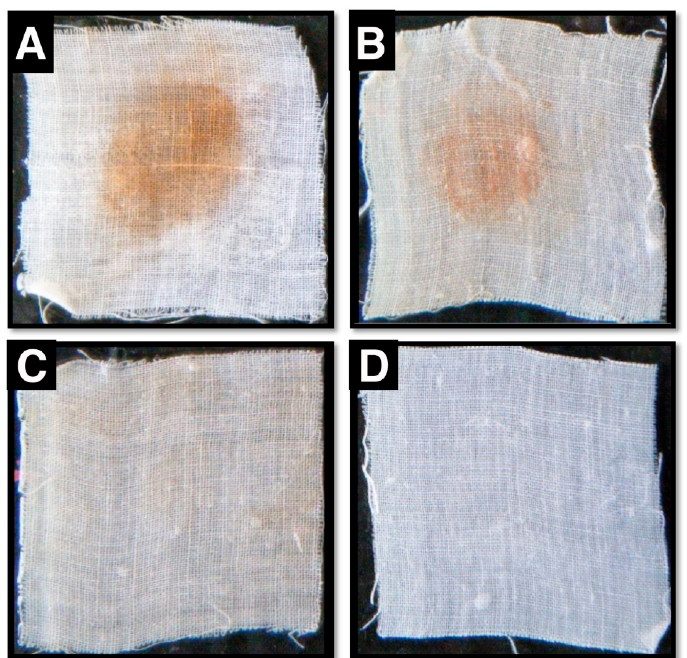
Figure 4. B. megaterium -TK1 protease-mediated cleaning performance of blood-stained fabrics. ( A ) Blood-stained fabric control. ( B ) Blood-stained fabric cleaned with detergent. ( C ) Blood-stained fabric cleaned with protease. ( D ) Blood-stained fabric cleaned with detergent and protease. Fotos were taken from cotton fabric square pieces (4 cm × 4 cm). Biology 2020 , 9 , x